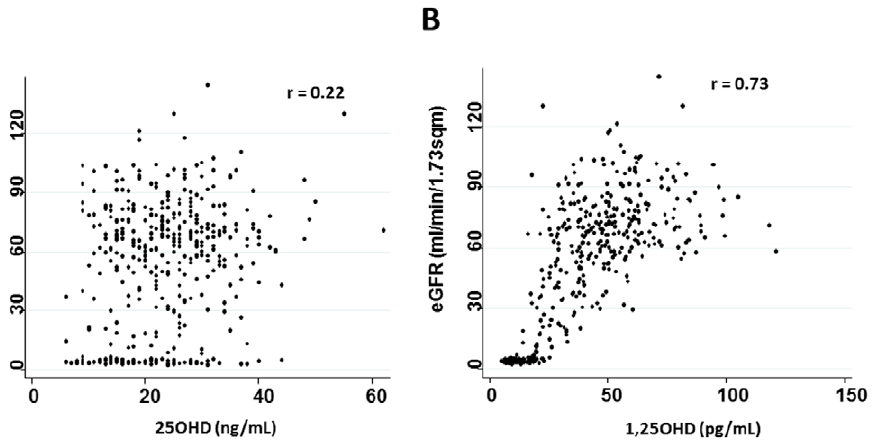
Figure 3. Two-way scatter graph for eGFR vs. 25OHD (A) or eGFR vs. 1,25OHD (B) in patients with type 2 diabetes and with CKD stage 1 , 5.